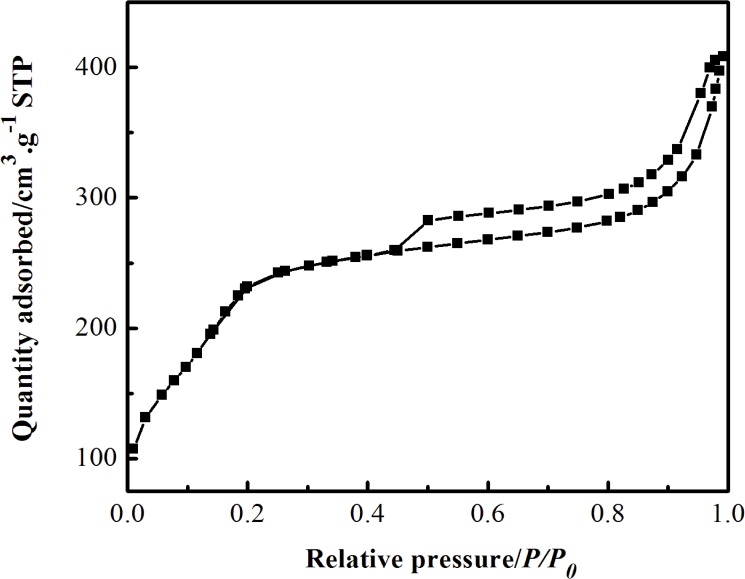
N2 adsorptionedesorption isotherms of Ag-TS at 77 K.